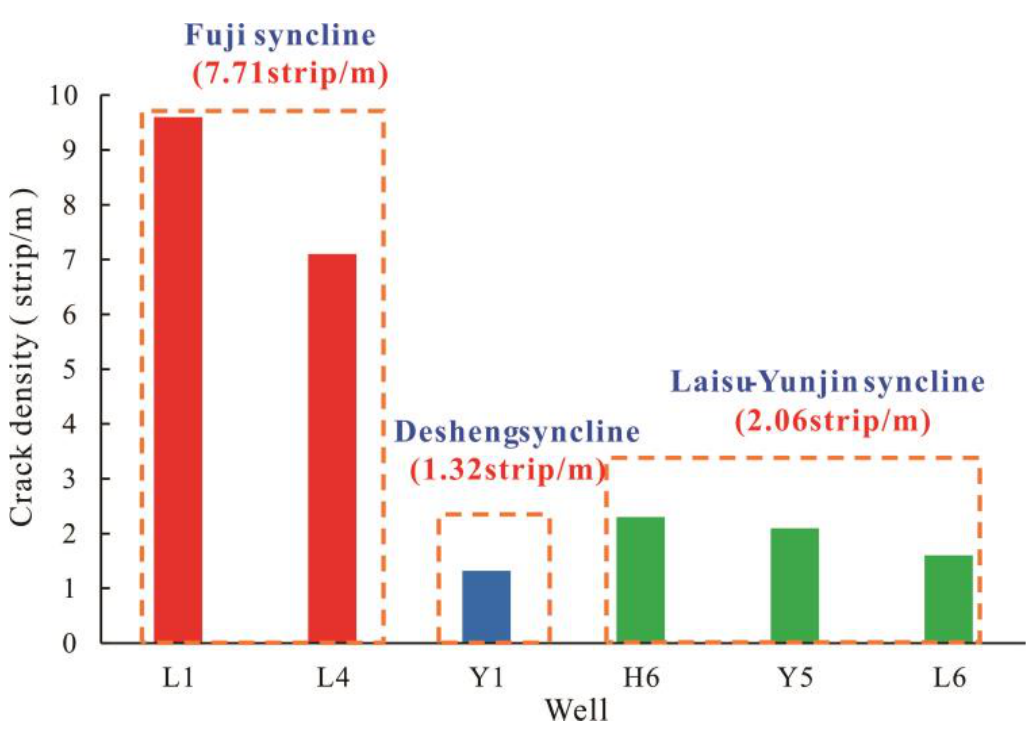
Figure 13. The fracture development degree of the different tectonic units in the Luzhou area.